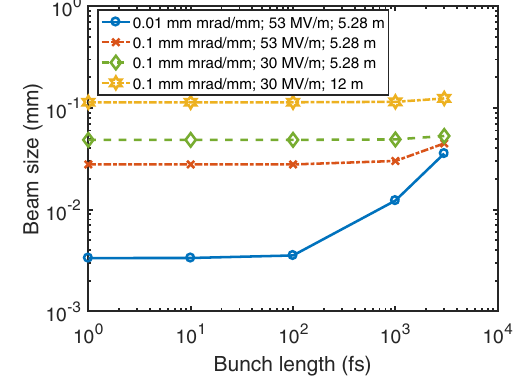
FIG. 6. The beam size evolution with the bunch length. The items in the legend are the normalized cathode transverse momentum, the peak cathode field and the distance from the cathode to the screen, respectively.